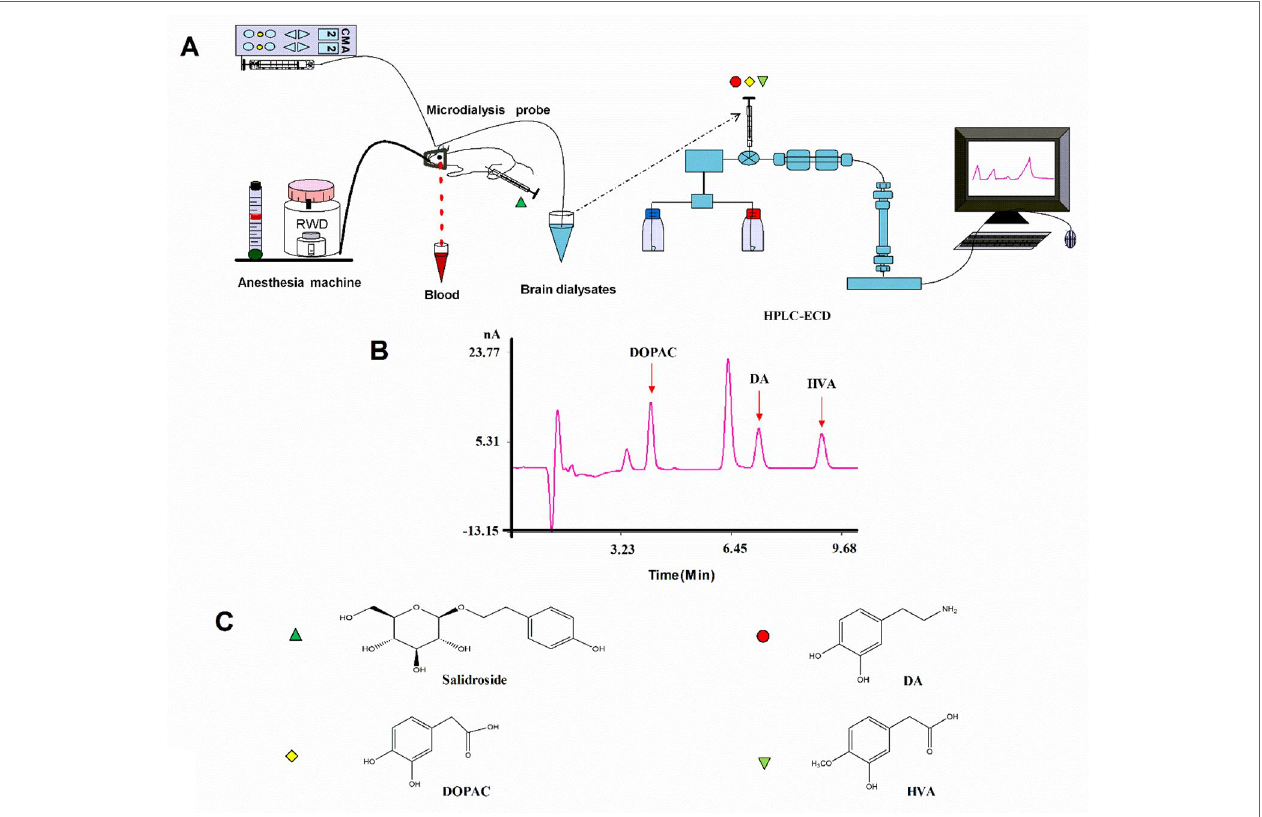
FIgURE 2 | (a) Schematic illustration of the experimental protocols. (B) HPLC-ECD analysis of DA, DOPAC, and HVA in striatal fluid samples. (C) Chemical structures of salidroside, DA, DOPAC, and HVA. HPLC-ECD high-performance liquid chromatography coupled with electrochemical detection, DA dopamine, DOPAC , 3,4-dihydroxyphenylacetic acid, HVA homovanillic